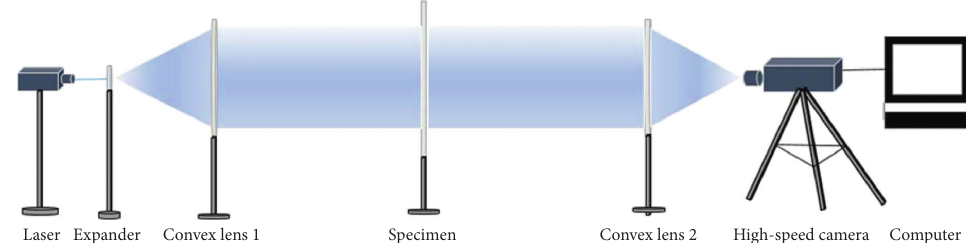
Figure 1: Digital laser dynamic caustics experimental system.